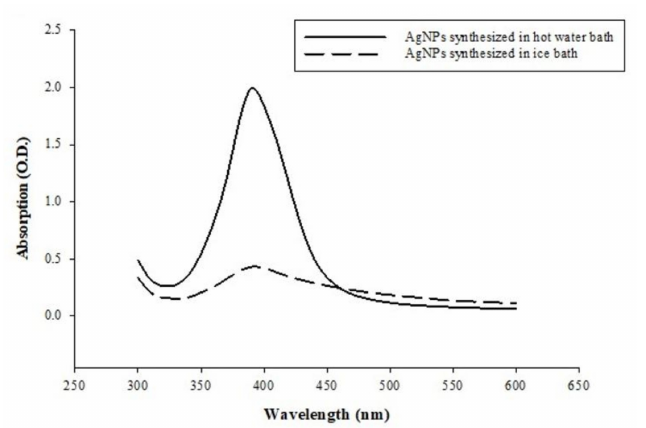
Figure A1. Effects of reaction temperature on the formation of AgNPs: UV–Vis spectrum ( λ = 300–600 nm) of silver nanoparticles. Silver nanoparticles synthesized by silver nitrate, trisodium citrate, and sodium borohydride at different